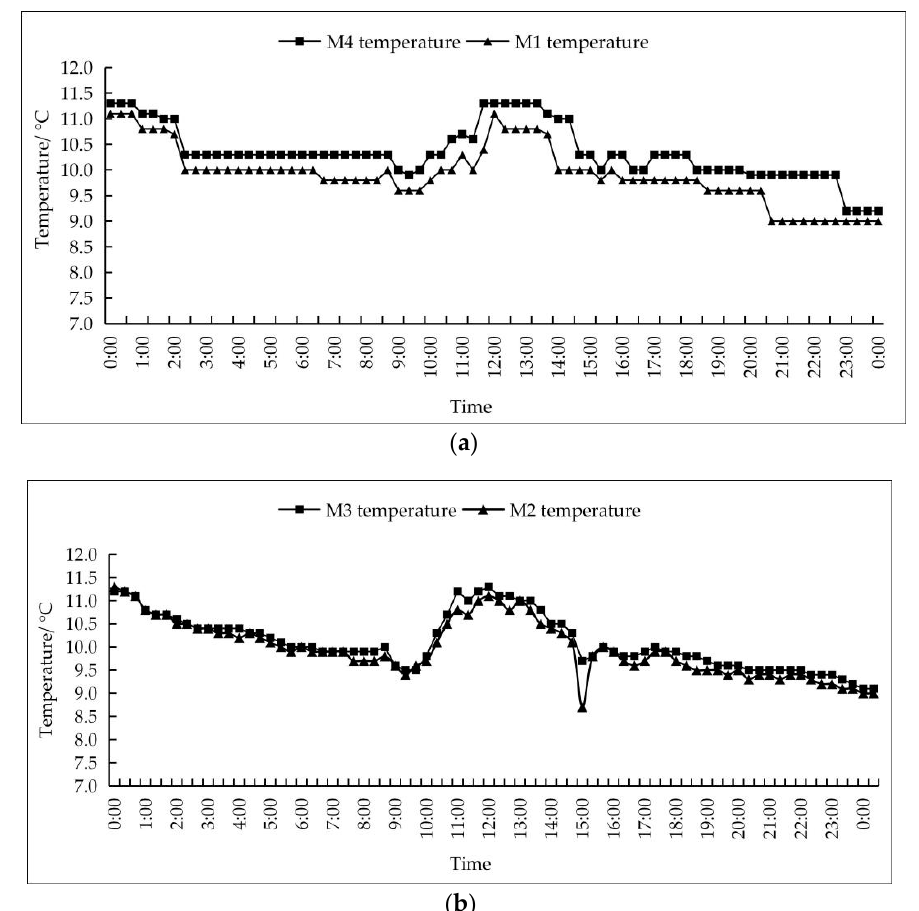
Figure 6. Temperature changes in greenhouses during rainy days on 16 February 2022. ( a ) Temper- ature changes of M2 and M3 measuring points; ( b ) Temperature changes of M1 and M4 measuring points.